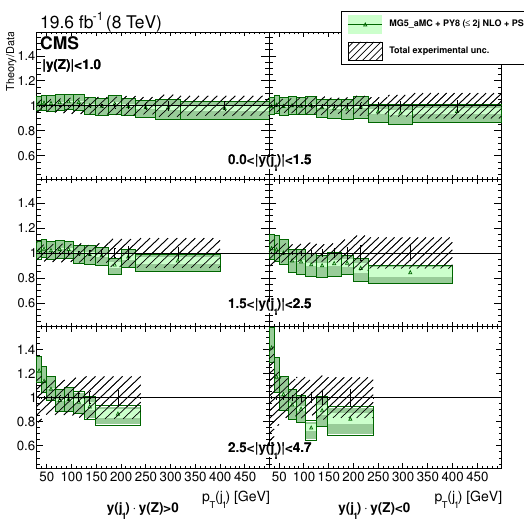
Figure 42 . Ratio to the measurement of the di(cid:11)erential cross section d 3 (cid:27)= d p T (j )d y (j )d y (Z) 1 1 obtained with mg5 a mc + pythia 8, with up to two jets at NLO, for j y (Z) j < 1. Left column corresponds to y (j ) y (Z) > 0 and right column to y (j ) y (Z) < 0. The total experimental uncertainty 1 1 is shown as a band around 1. Uncertainties in the predictions are shown on the ratio points and include the statistical, theoretical, and PDF uncertainties. The dark green area represents the statistical and theoretical uncertainties only, while the light green area represents the statistical uncertainty alone.